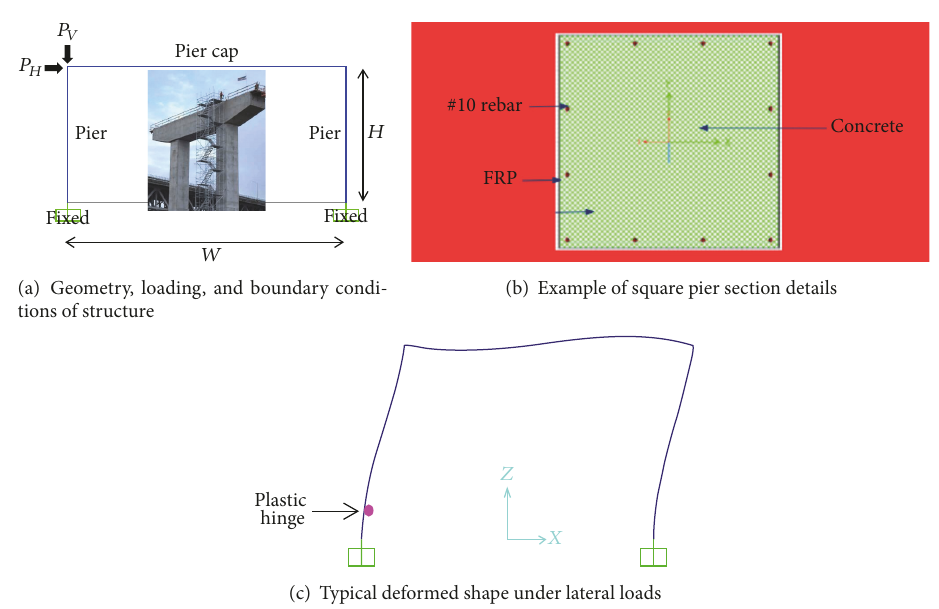
Figure 2: FE model development ( 𝑃 𝐻 = incremental lateral load; 𝑃 𝑉 = incremental vertical load; 𝑊 = length of pier cap; and 𝐻 = height of pier).